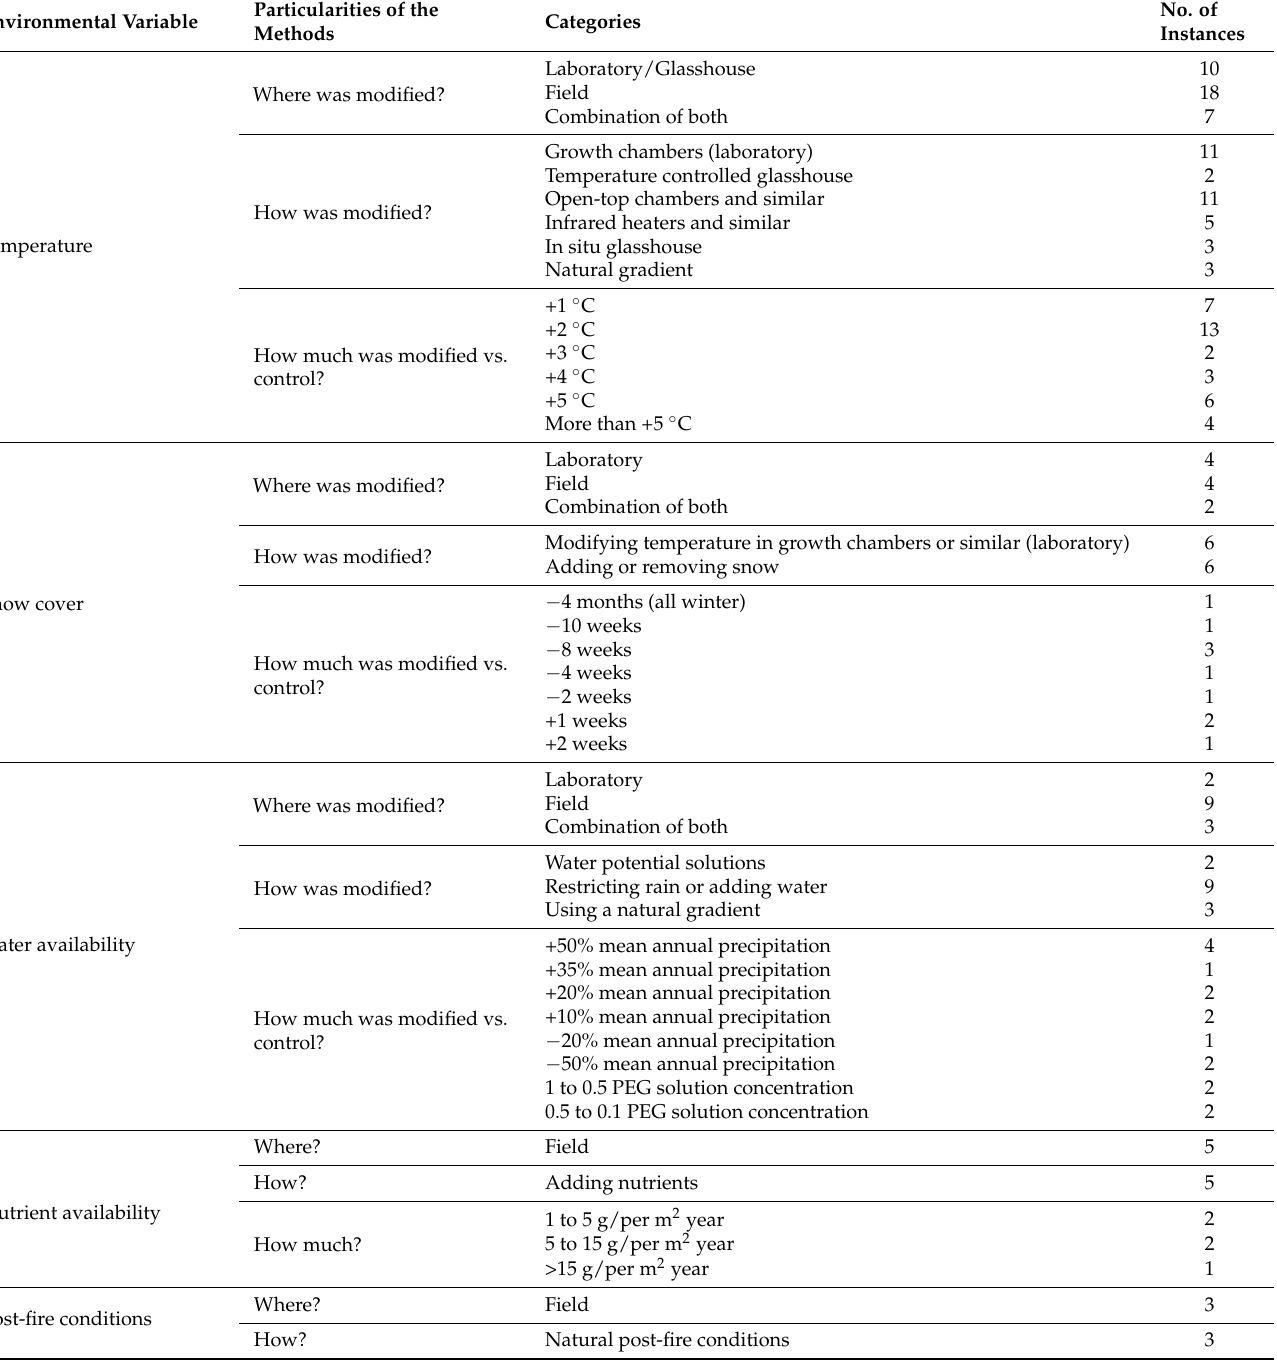
Table 1. The particulars of methods used by the studies within our review. The count of the number of instances could be more than the number specified for each environmental variable because more than one method or environmental variable may have been tested in each